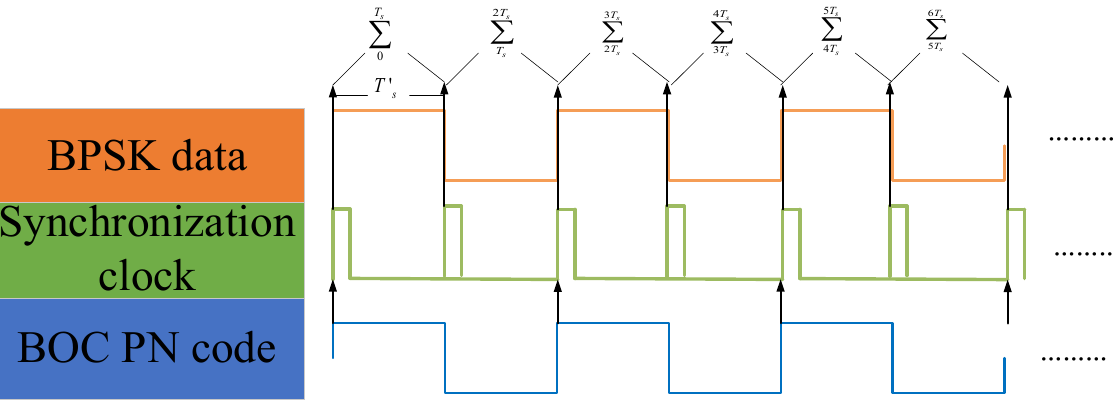
Figure 5. Bit synchronization and demodulation of the BPSK signal.